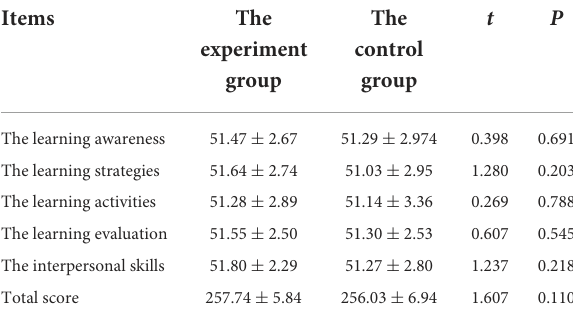
TABLE 4 The comparison of the self-directed learning ability between the two groups of intern nursing students before the